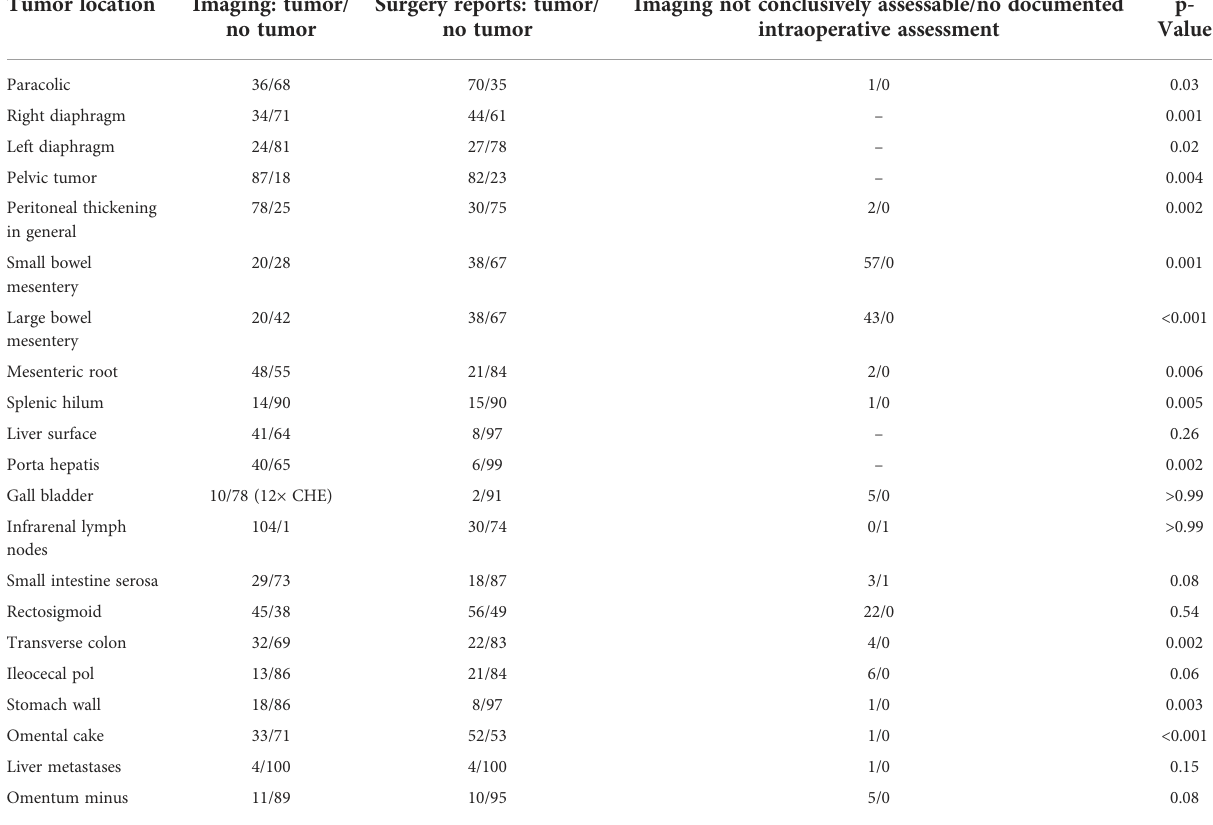
TABLE 2 Correlation of tumor location according to CT scan and according to surgery